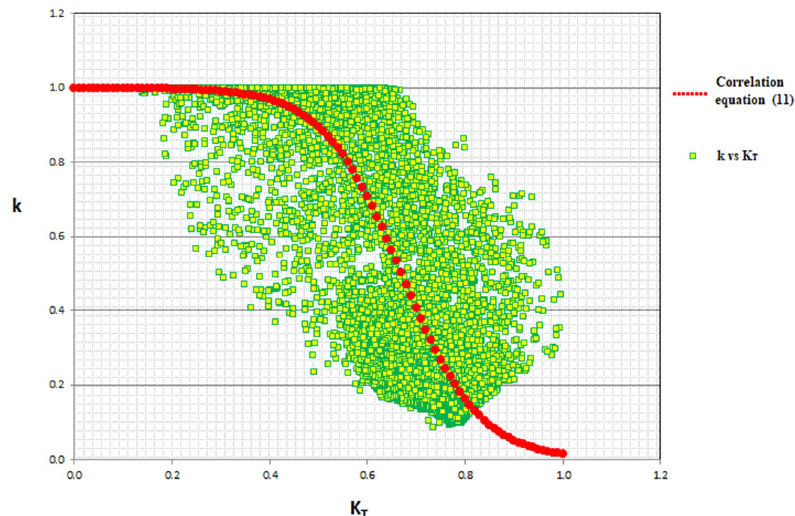
Figure 6. Dispersion graph of hourly parameter pairs of ( K T , k ), where K T is global transmission coefficient and k is the fraction of the diffused radiation with respect to global radiation with their correlation Equation (11) proposed by Reference [12] (in red).